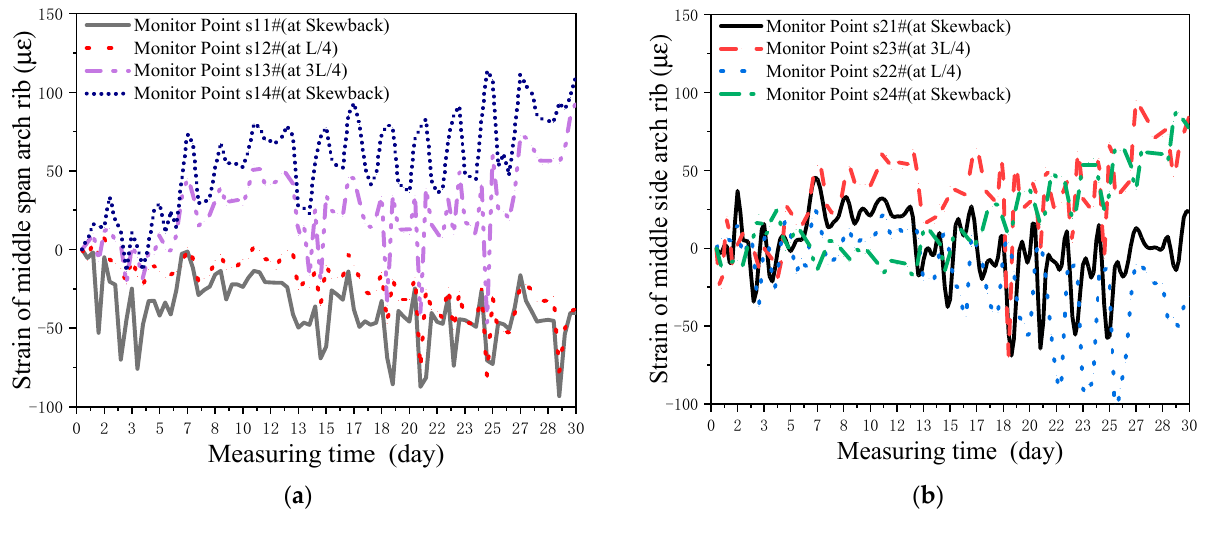
Figure 7. Monitoring results of strain: ( a ) Monitoring results of the strain of middle span; ( b ) Moni- toring results of the strain of side span.